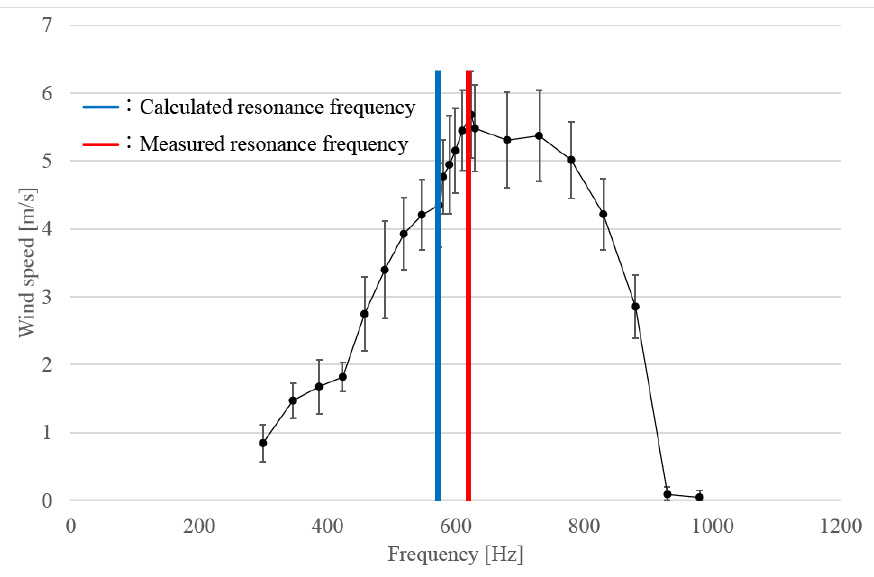
Figure 3. Wind velocity vs. frequency at 5.5 mm sound hole.